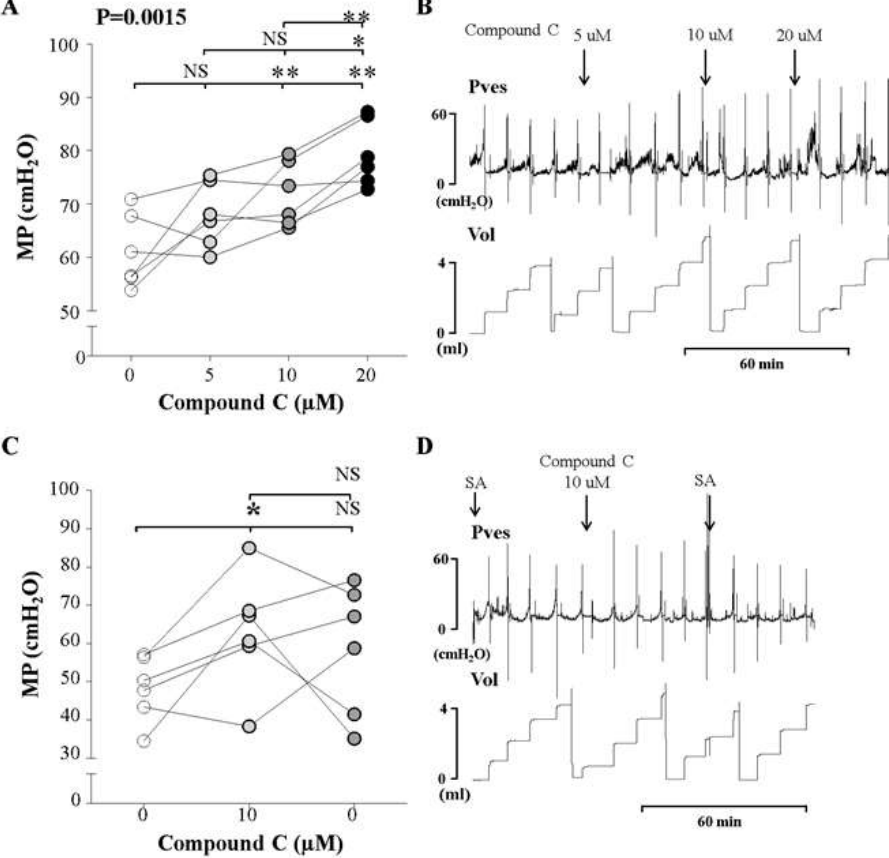
Figure 3. E ff ects and representative tracings of intravesical selective inhibitors of AMPK (compound C, A and B) with three consecutive increasing concentrations on the micturition pressure (MP) on cystometry, in order to identify the smallest dose showing a valid e ff ect. NS: not significant, * p < 0.05 and ** p < 0.01 compared to the control or the other dose; repeated one-way analysis of variance with the Dunnett post hoc test ( A , B ). Compound C increased the MP starting at an injected concentration of 10 µ M, compared to the control group ( C , D ). The inhibitor was injected into the bladder, followed by normal saline. We did not use analysis of variance here, because this sub-experiment was conducted to compare the e ff ects of injecting inhibitor and saline. Thus, we used the t -test for statistical comparisons between each event. NS: not significant, SA: saline. *: p < 0.05, compared to control ( C